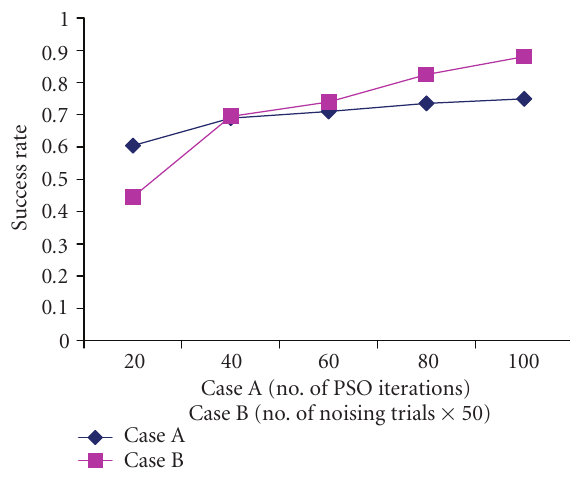
Figure 4.3 . Success rate versus number of iterations for network number 1.